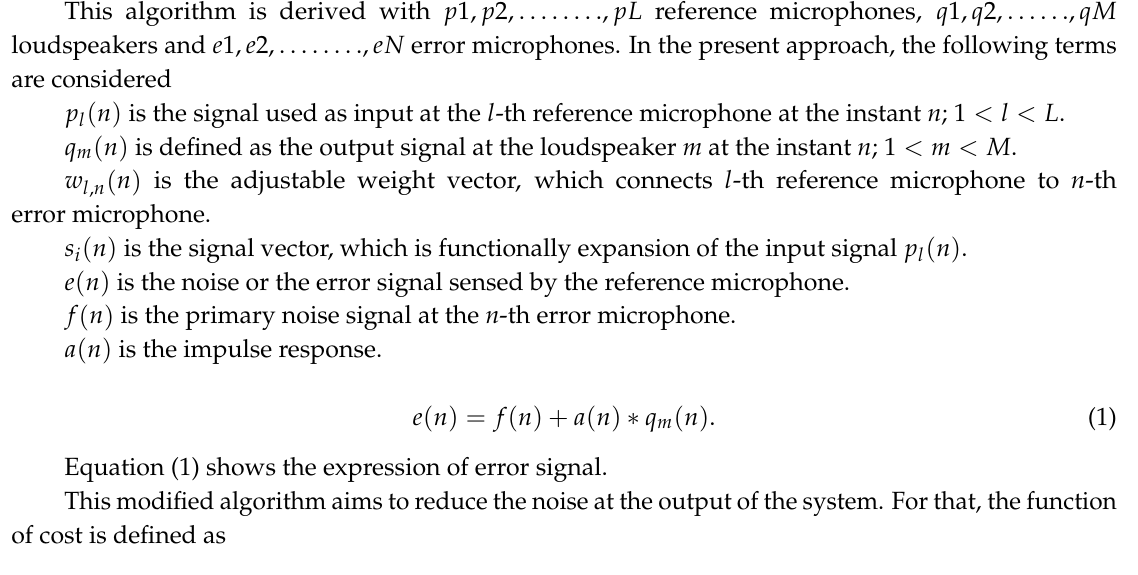
Figure 1. Schematic of MFsLMS based on multichannel ANC.